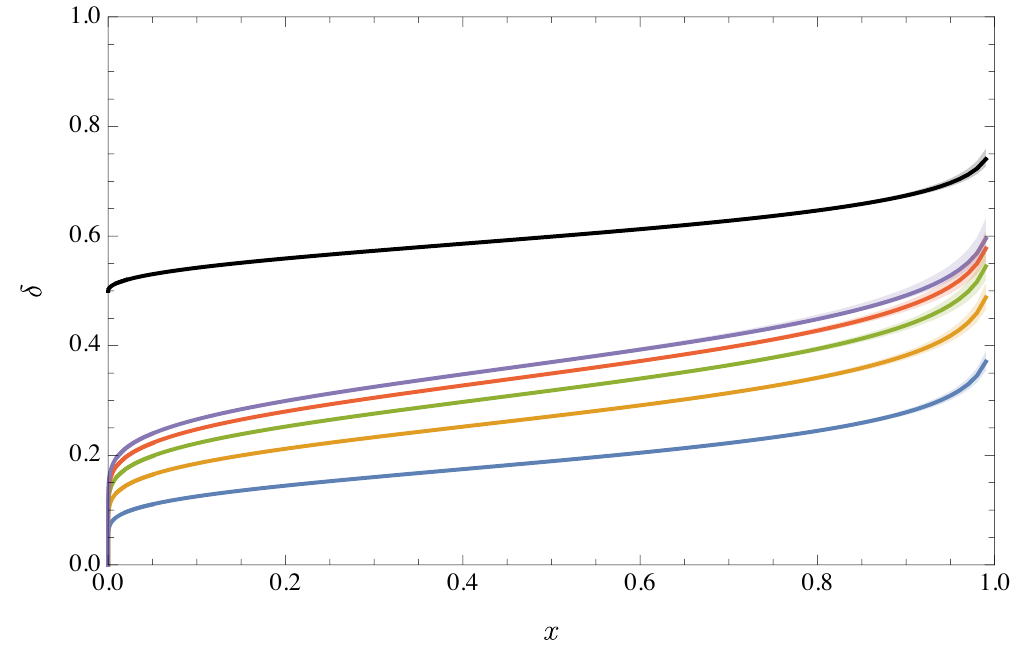
Figure 4. The critical dimension (cid:1) c = (cid:14) as a function of cross-ratio x for the handlebodies corre- sponding to the R(cid:19)enyi entropies of a pair of intervals. From top to bottom, the curves correspond to genus 2 ; 3 ; 4 ; 5 ; 6, and (cid:12)nally the n ! 1 result in black. The shading visible on the right side of the plot indicates the bounds achieved by applying McMullen’s algorithm at the crudest level of